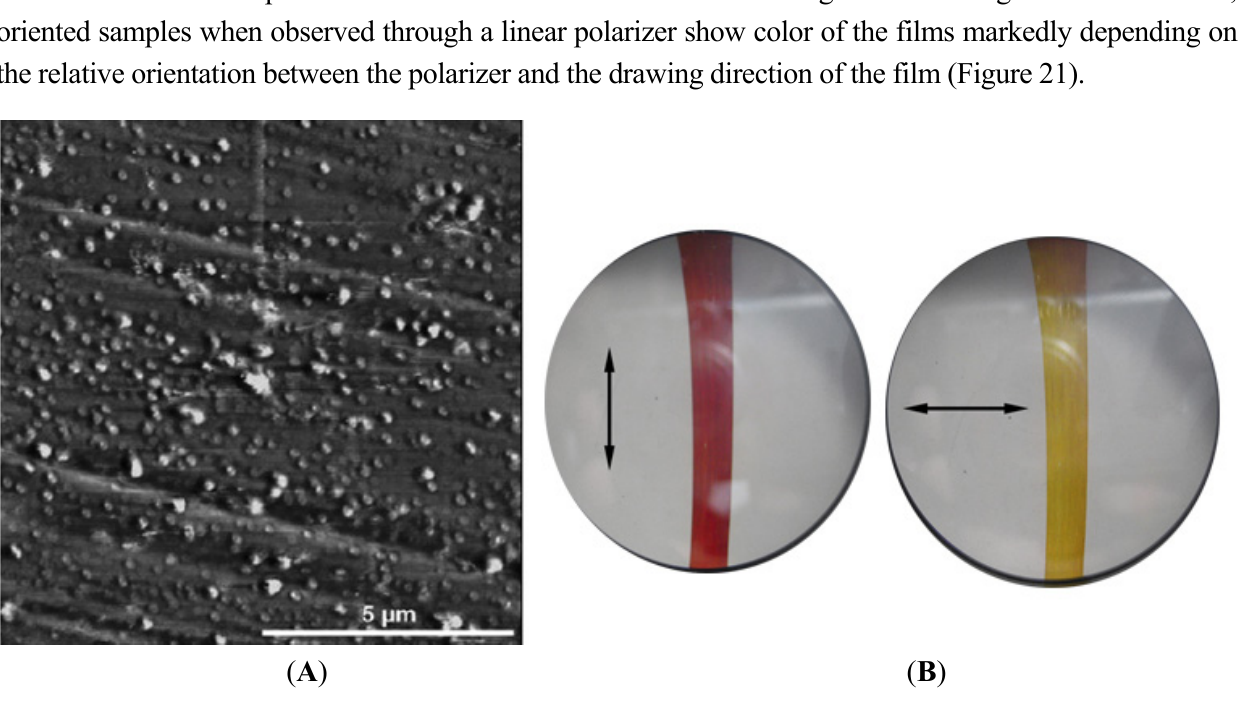
Figure 21. AFM image of a Ag/PVA-B120 film ( A ); Images of oriented Ag/PVA-A120 film ( B ) with polarization direction of the incident light parallel (left) and perpendicular (right) to the drawing direction. Adapted from Bernabò